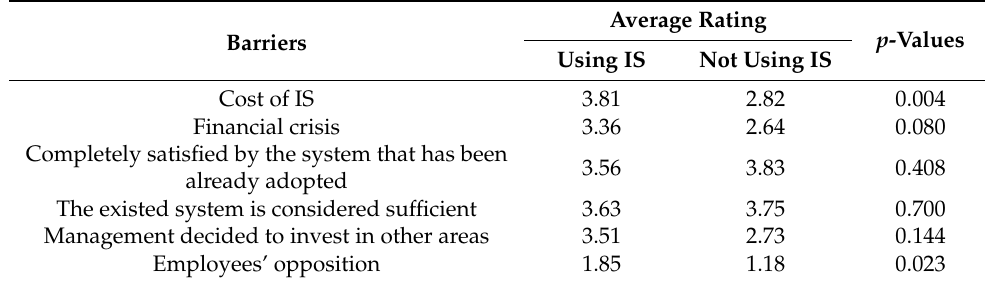
Table 3. Barriers of IS adoption—use of information systems.